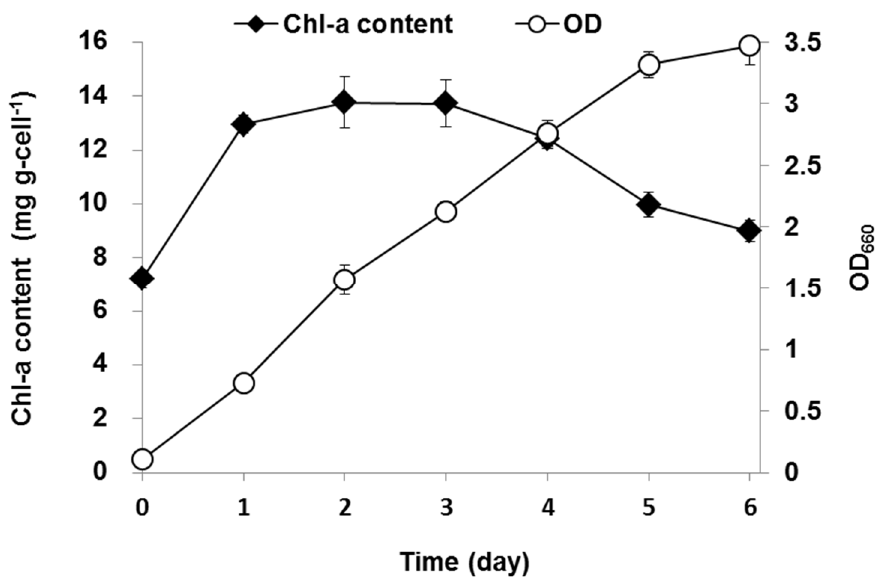
Figure 3. Variations in chlorophyll-a (Chl-a) content and optical density (OD 660 ) over time under a mixotrophic cultivation. Artificial wastewater was prepared in a modified BG11 medium with NaHCO 3 0.5 g-C L − 1 and glucose 0.5 g-C L − 1 (error bars denote standard deviation ( n = 3)).